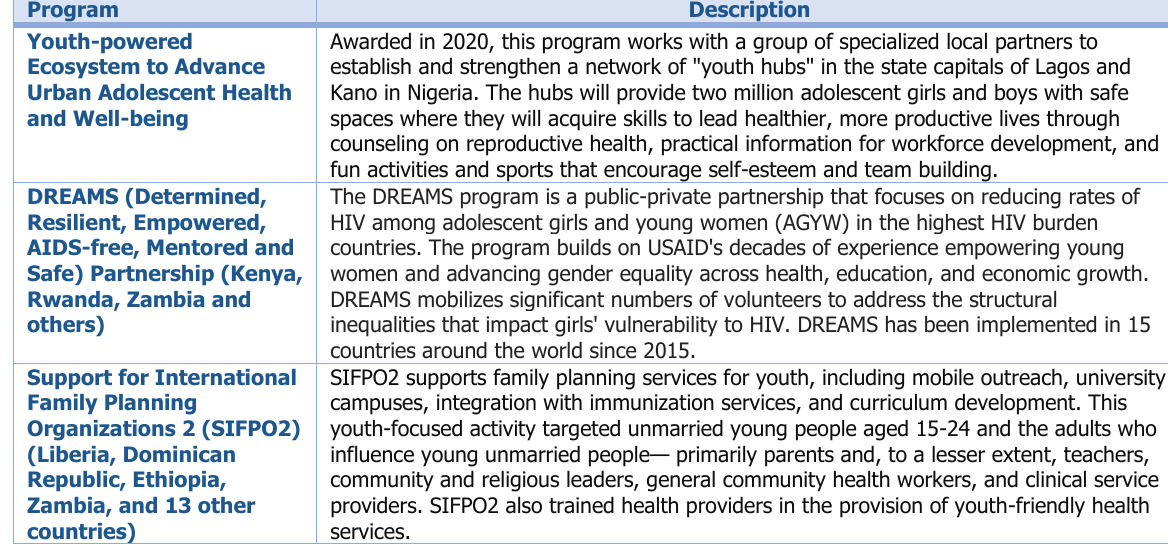
Table 9. Exemplar Programs Targeting Improvements in Youth